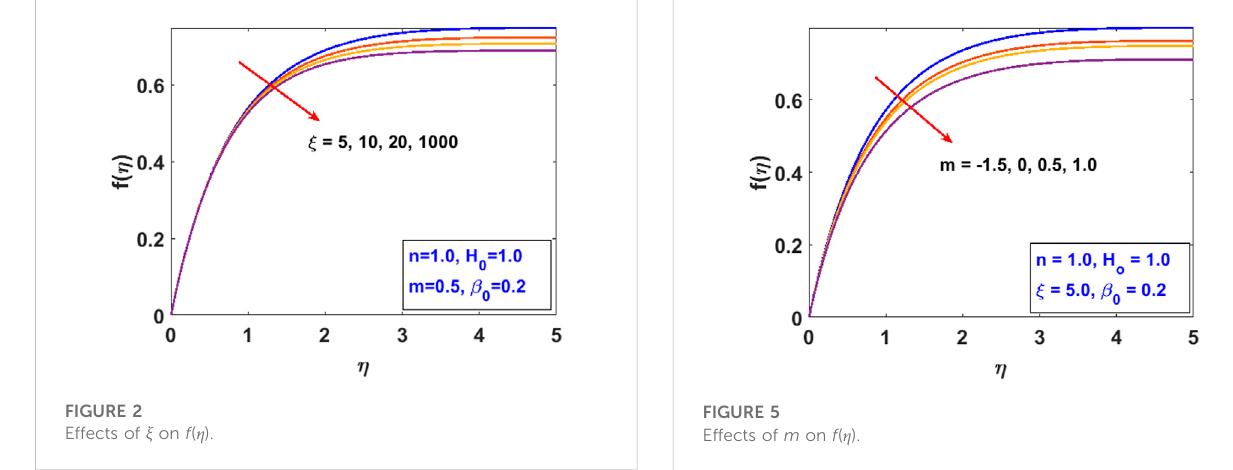
FIGURE 5 Effects of m on f ( η ).